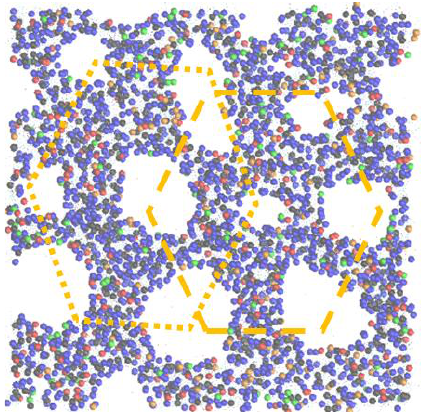
Figure 13. A snapshot for the top view of IMP301 bilayer at the end of simulation. Pore arrangement is highlighted as yellow hexagons. Phosphate beads of DSPC, DSPE-PEG, DOPE, MSPC, and hydroxyl beads of cholesterol are presented as thick dots colored in red, orange, blue, green, and black, respectively.